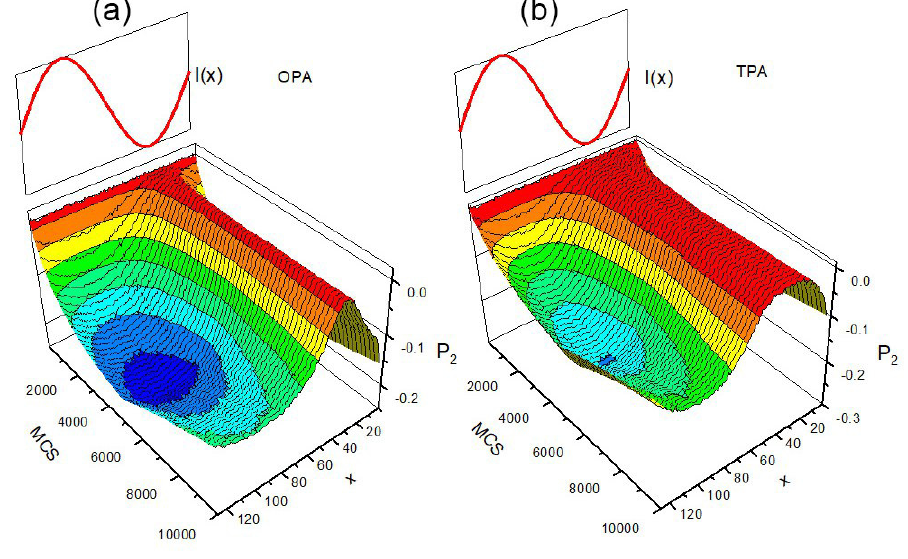
Figure 20. MC-time evolution of order parameter P 2 ( x ) for OPA ( a ) and TPA ( b )